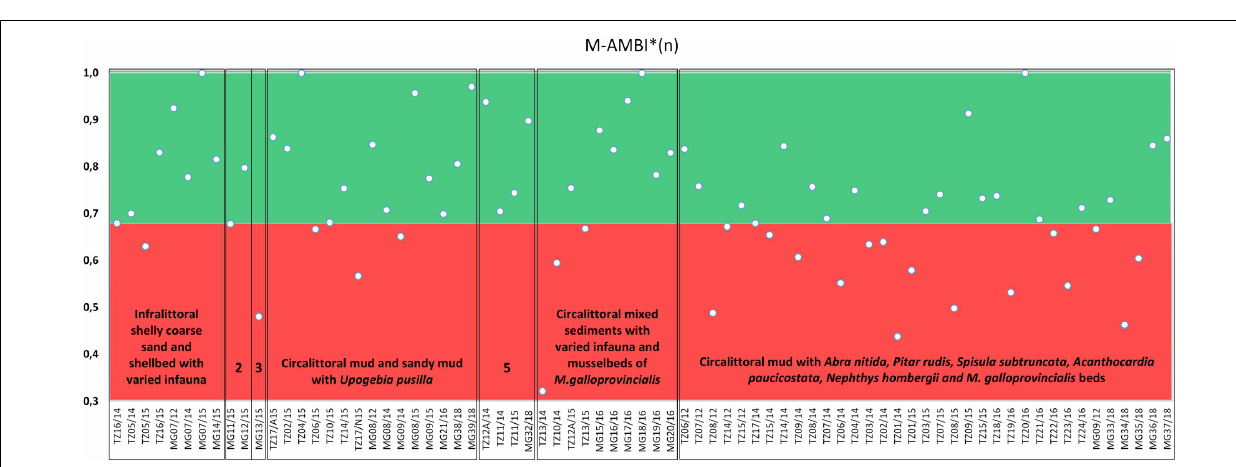
FIGURE 8 | Diagram illustrating the variation in ecological state in the seven habitats analyzed based on M-AMBI ∗ ( n ) values (Sigovini et al., 2013). The background colors distinguish samples from both MPAs in good ecological status (GES; green) and non-GES